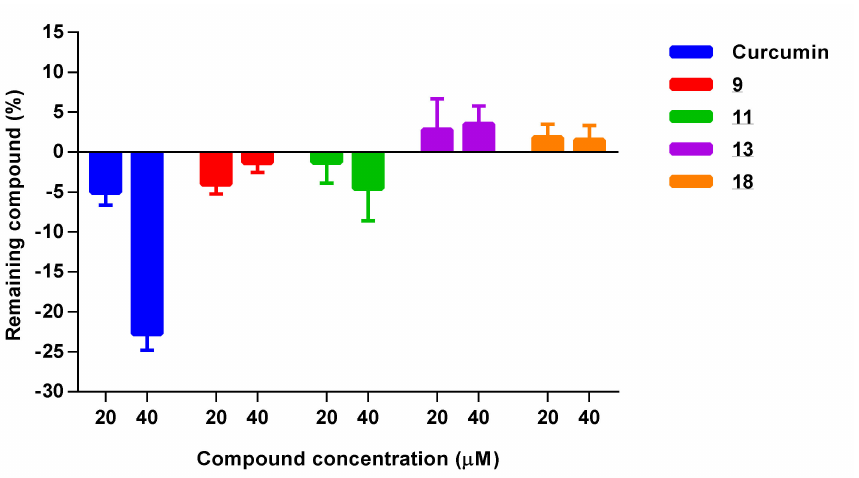
Figure 5. Reactivity of curcumin and compounds 9 , 11 , 13 , and 18 with H 2 O 2 500 µ M in DMEM:F12 medium (without cells, FBS, and phenol red) at 37 ◦ C for 4 h. Results represent the concentration decrease (%) for each compound. Values are the mean ± SD of two experiments performed on different days and carried out in quadruplicate in 96-well culture